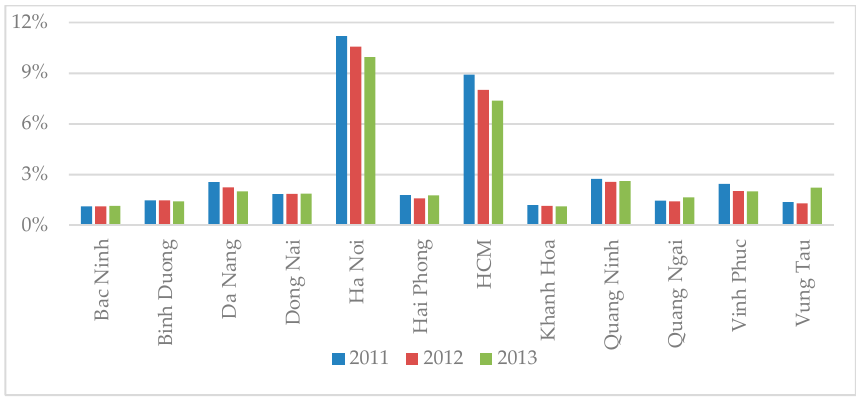
Figure 2. Fiscal importance ratio of selected provinces in Vietnam over the 2011–2013 period.